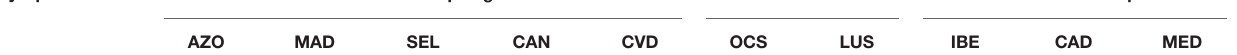
TABLE 1 | Spatial and bathymetric distribution of lithistid sponges (Porifera, Demospongiae, Heteroscleromorpha) across the Northeast Atlantic and Mediterranean Sea. Family/Species Oceanic archipelagos